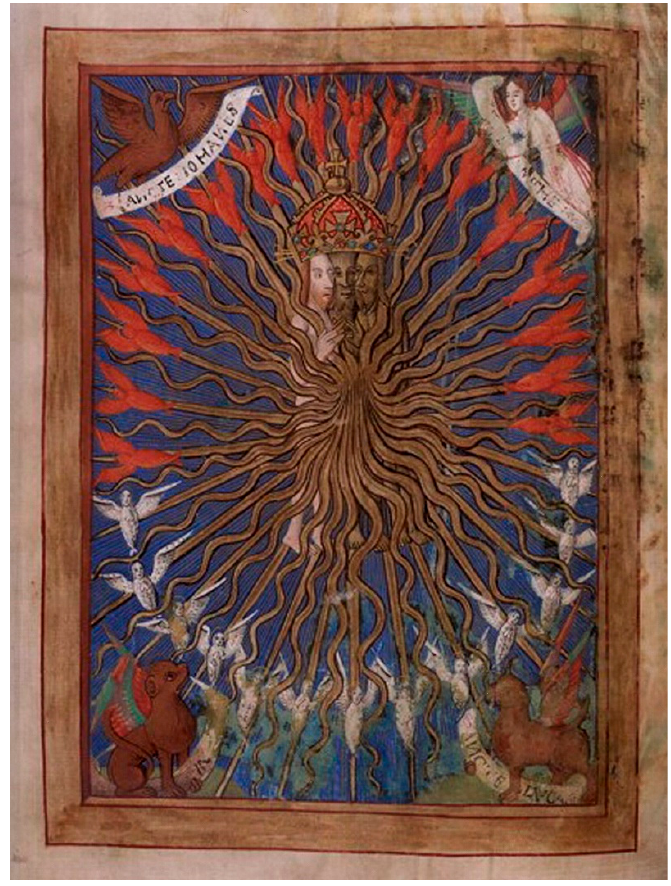
© British Library